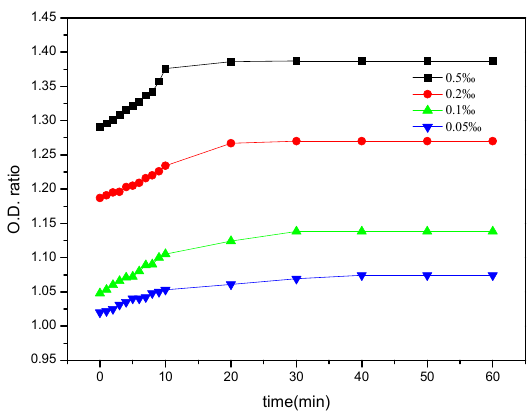
Figure 4. Dynamic UV absorption of E. coli with various concentrations of GCS (DS = 25.5%).